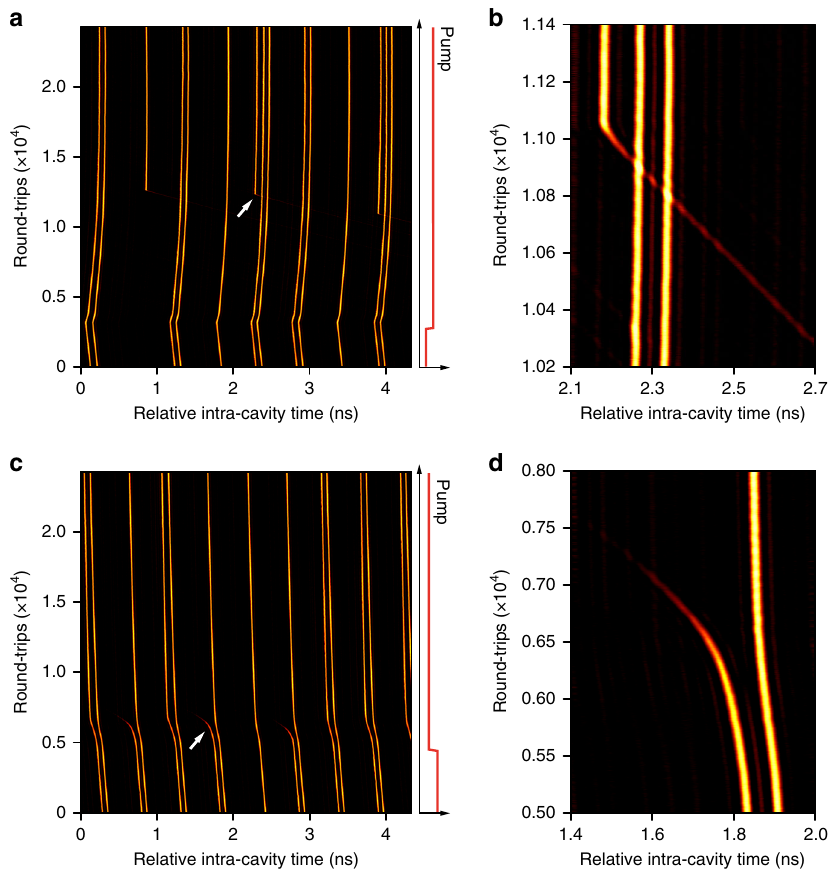
Fig. 5 Addition and removal of solitons to and from supramolecular structures. a , b An abrupt jump in EDFA pump power leads to the addition of solitons to a soliton supramolecule without destroying its basic structure. c , d Removal of some solitons from a soliton supramolecule can also be achieved by decreasing the pump